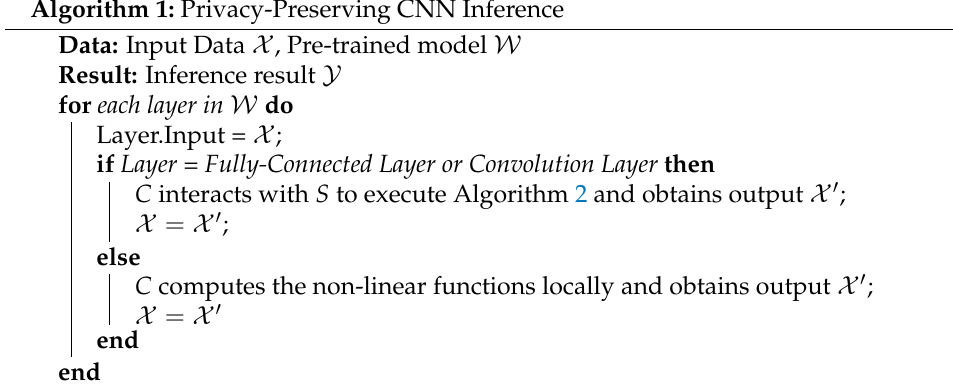
Algorithm 1: Privacy-Preserving CNN